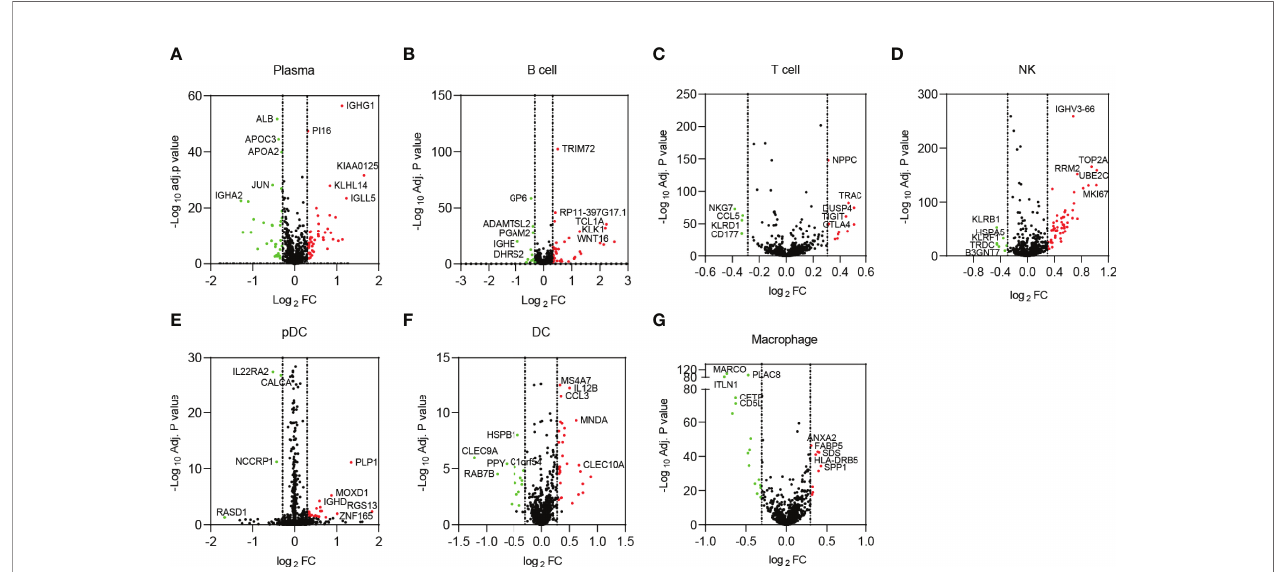
FIGURE 2 | DEGs in immune cells. (A) Plasma cells. (B) B cells. (C) T cells. (D) NK cells. (E) pDCs. (F) DCs. (G) Macrophages. The dots in red represent upregulated genes, and the dots in green represent downregulated genes. DEGs, differentially expressed genes; NK, natural killer; pDCs, plasmacytoid dendritic